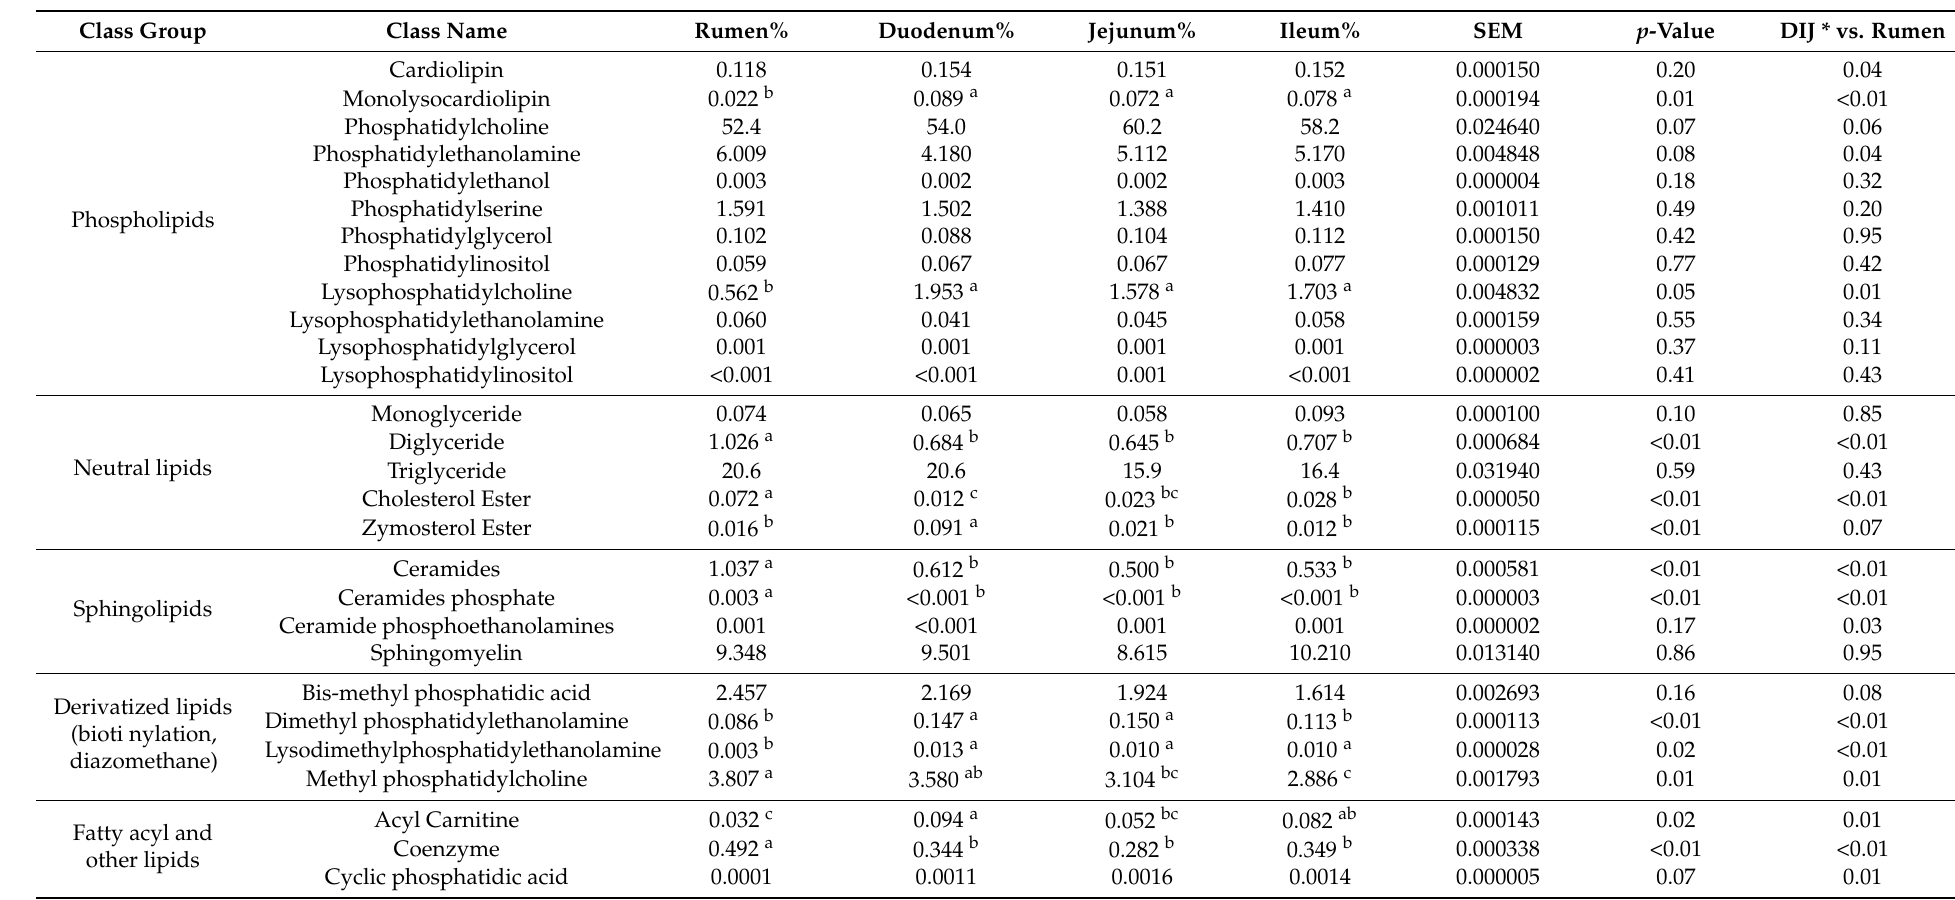
Table 1. Relative abundance, SEM, and p -value of common lipid classes across the ruminal papillae and epithelium from duodenum, jejunum, and ileum of 5 lactating Holstein